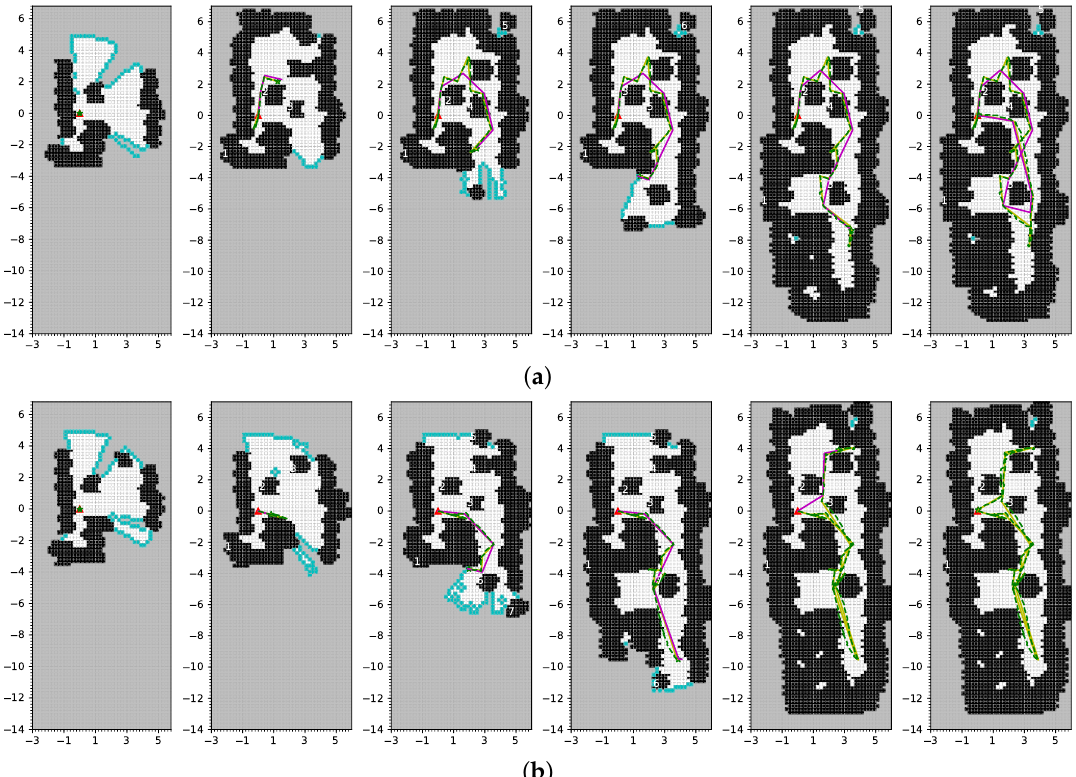
Figure 9. Snapshots of map building during during the real world experiment. Standard frontier-based exploration is shown in ( a ), and our proposed approach is shown in ( b ). The tether approximation during the exploration is shown in